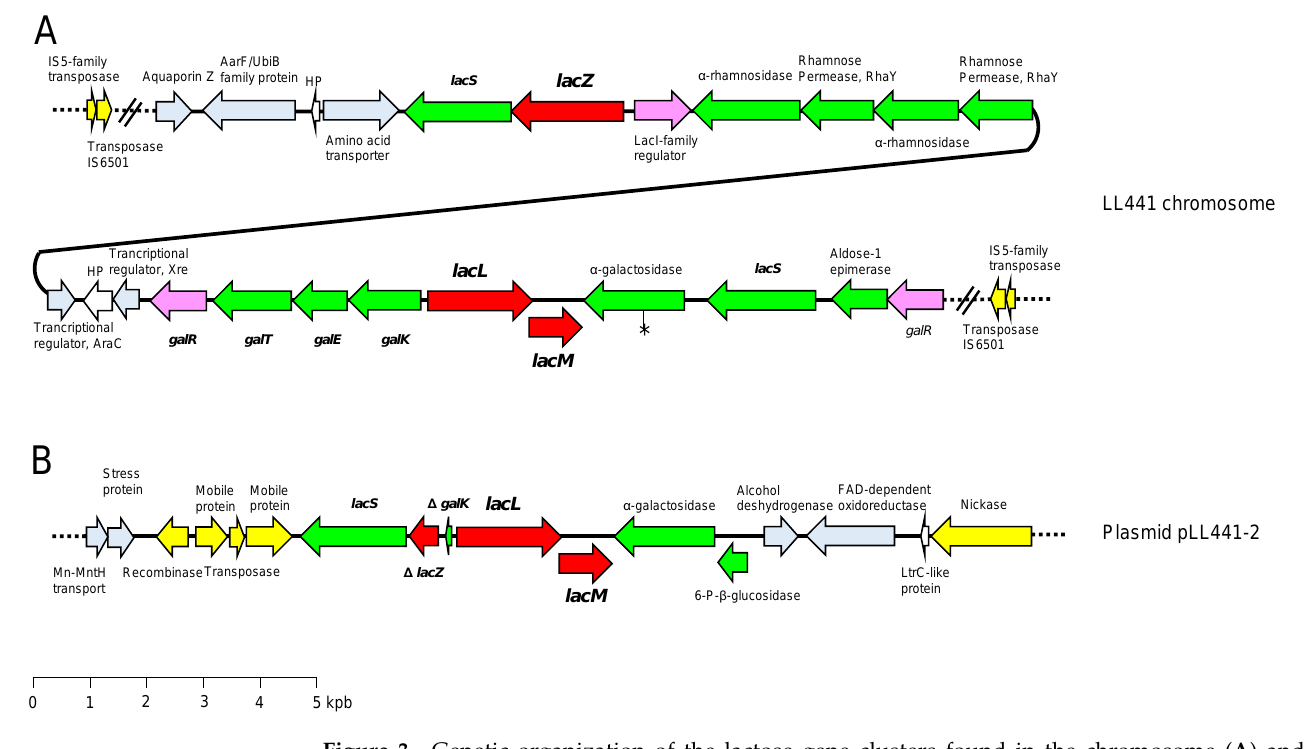
Figure 3. Genetic organization of the lactose gene clusters found in the chromosome ( A ) and plasmid pLL441-2 ( B ) of the L. plantarum LL441 genome. Colour code: in red, genes coding for β -galactosidases, lacZ, and lacLM ; in green, genes for carbohydrate transport and metabolism systems; in light purple, genes encoding regulatory proteins; in yellow, open reading frames (ORFs) encoding transposases or mobilization proteins; in light blue, other genes; in white, genes encoding hypothetical proteins (HP). The asterisk in the chromosomal copy of the α -galactosidase ORF denotes a point mutation disrupting the gene. The rhaY and araC genes, linked by a black line, are contiguous in the chromosome. The dotted lines at the end of the clusters and the crossed lines indicate the continuity of the regions.